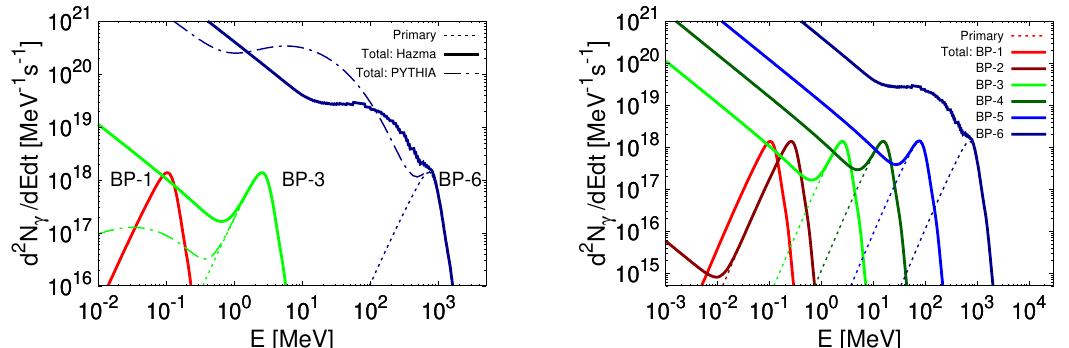
Figure 1 . Left panel: instantaneous photon spectra from PBH evaporation using BlackHawk with Hazma and with PYTHIA for three benchmark points. The Hazma and PYTHIA spectra are identical for BP-1 , which has a relatively heavy PBH mass. Note the large differences in the secondary contributions for BP-3 and BP-6 . Right panel: the photon spectra for all six benchmark points in table